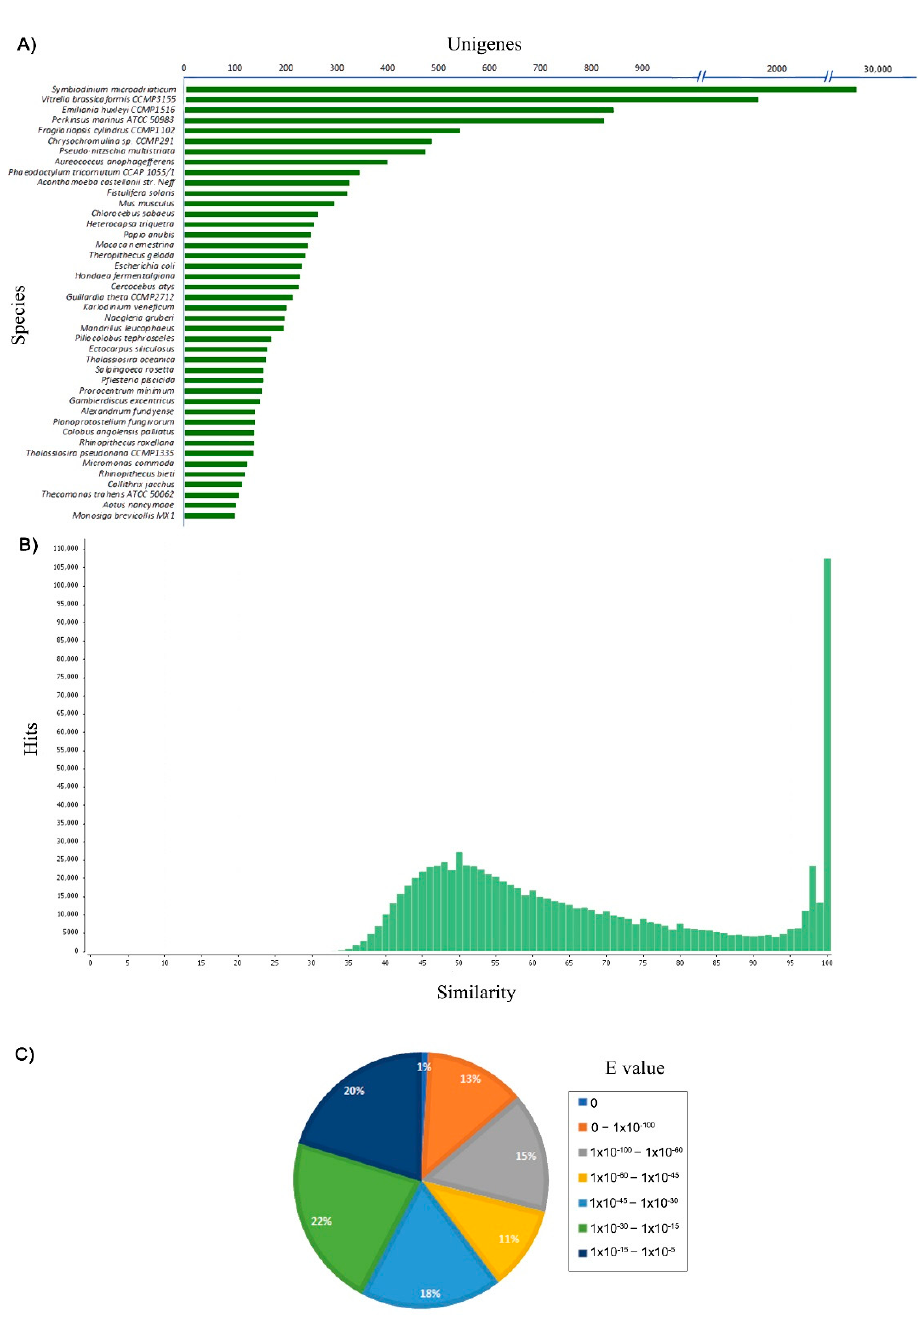
Figure 2. Annotation of A. minutum unigenes against the NCBI-NR database. ( A ) The homological species distribution for A. minutum . ( B ) The percentage of similarity of sequences identified using blastx program and ( C ) the distribution of E values of the blastx hit.